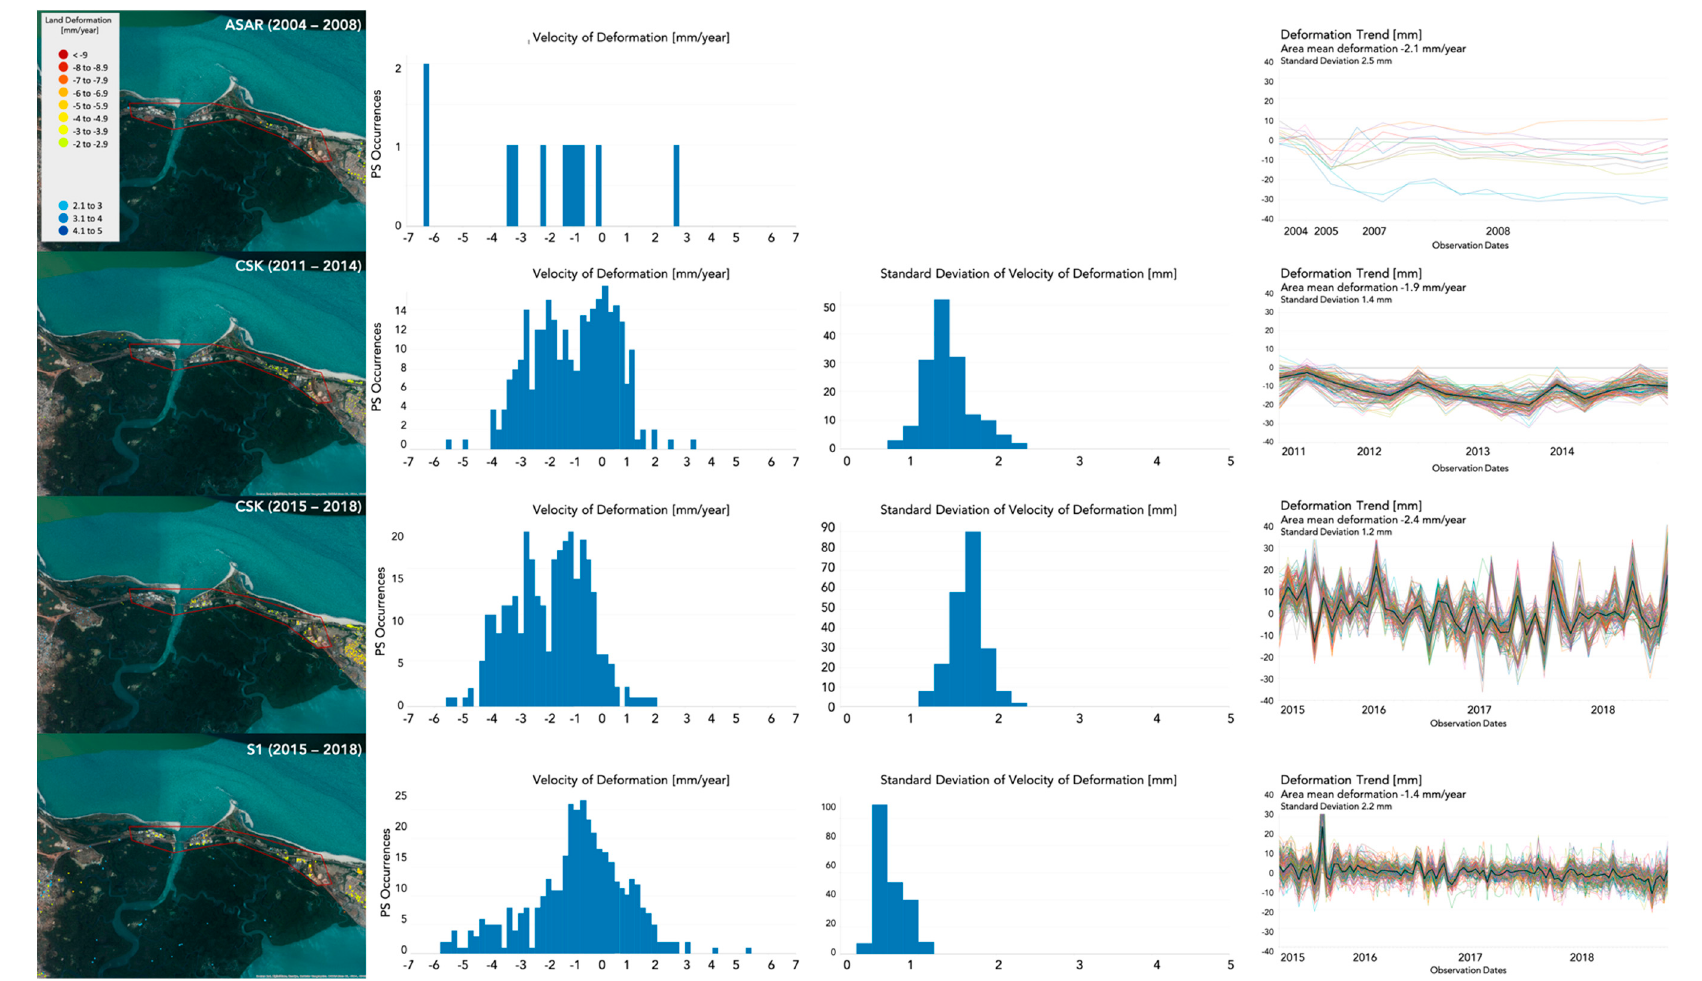
F igure 16. Banjul AOI 5. Figure 16. Banjul AOI